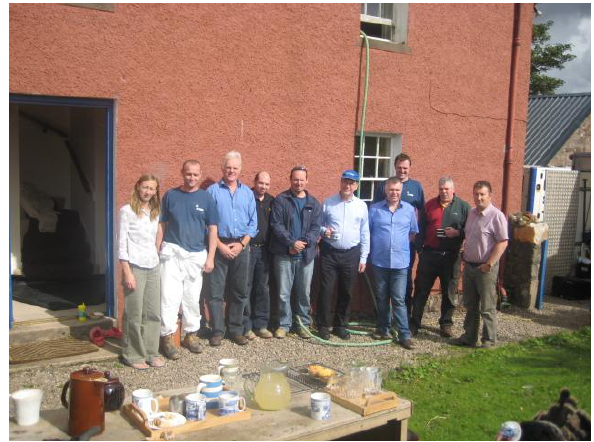
Figure 19. Part of the team involved in the trial The home